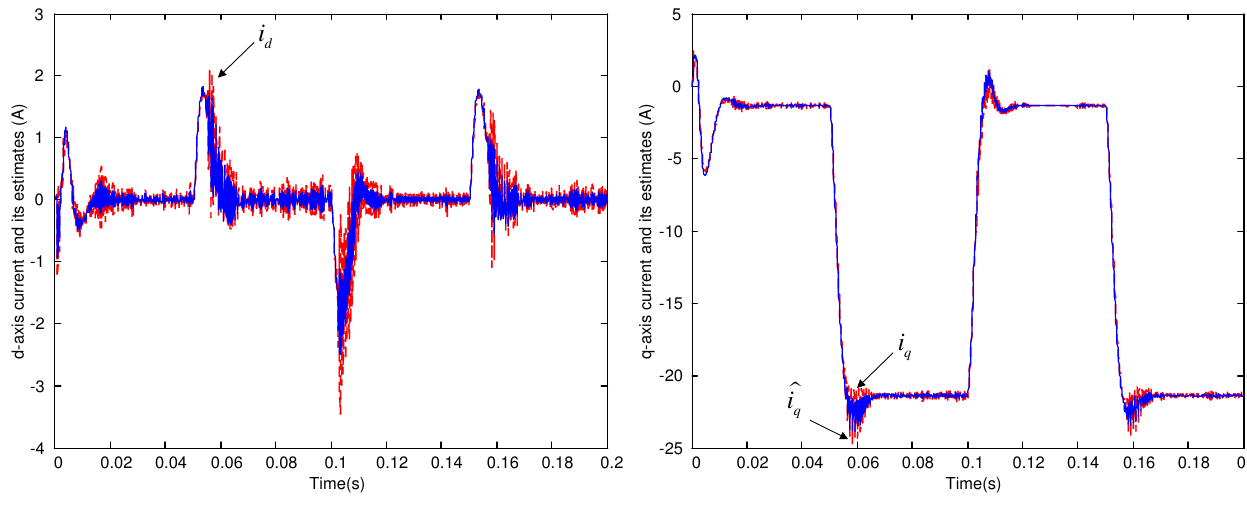
Figure 6. ( Left ) d -frame current reference estimation performance; ( Right ) q -frame current